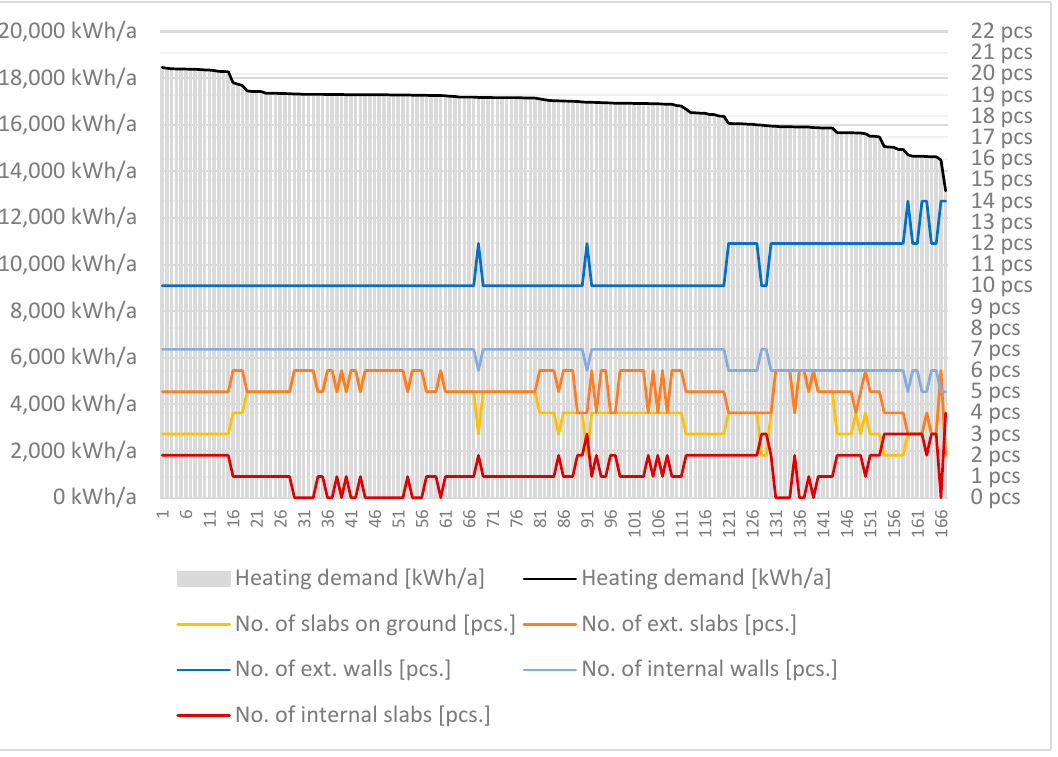
Figure 13. Heating energy demand [kWh/m 2 a] of the 167 batches with indicated amount of external heat loss surface and internal connection surface in each configuration.